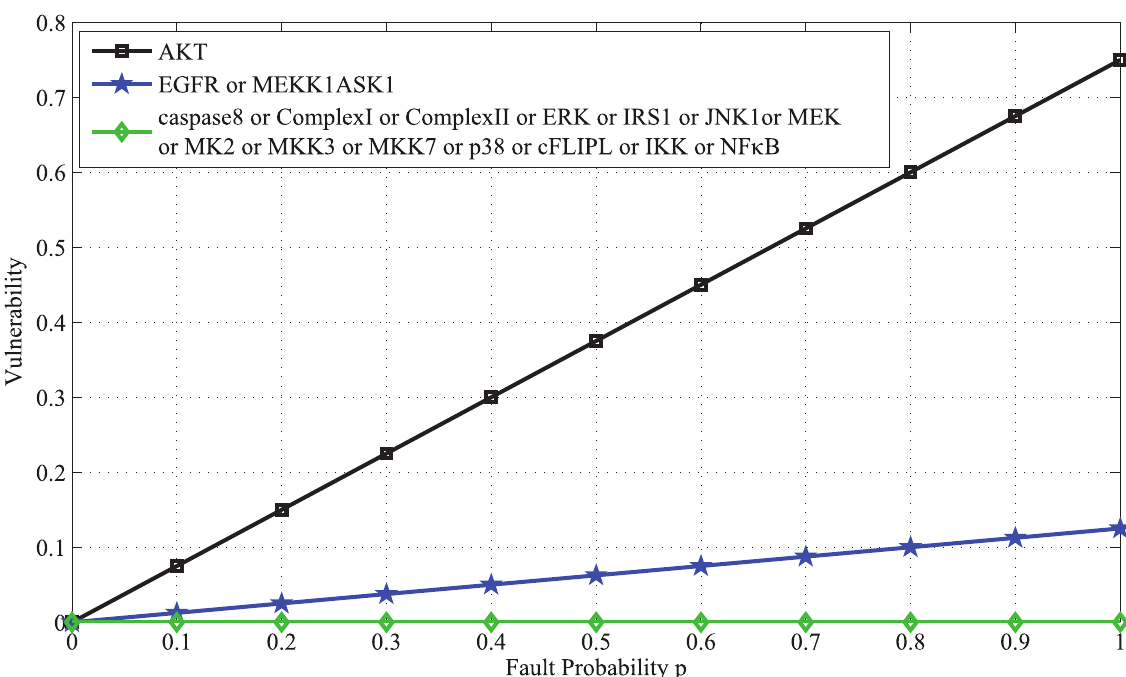
Figure 2. Vulnerability versus the fault probability p of each molcule in the caspase3 network. Vulnerability, which is the probability of the network function failure, shows a non-decreasing trend as the fault probability of a molcule increases. Vulnerability is the highest when AKT is faulty (black graph). When EGFR or MEKK1ASK1 is faulty, vulnerability is the same (blue graph), but less than AKT’s vulnerability. Vulnerability is zero (green graph), when each of the rest of the molecules is faulty.